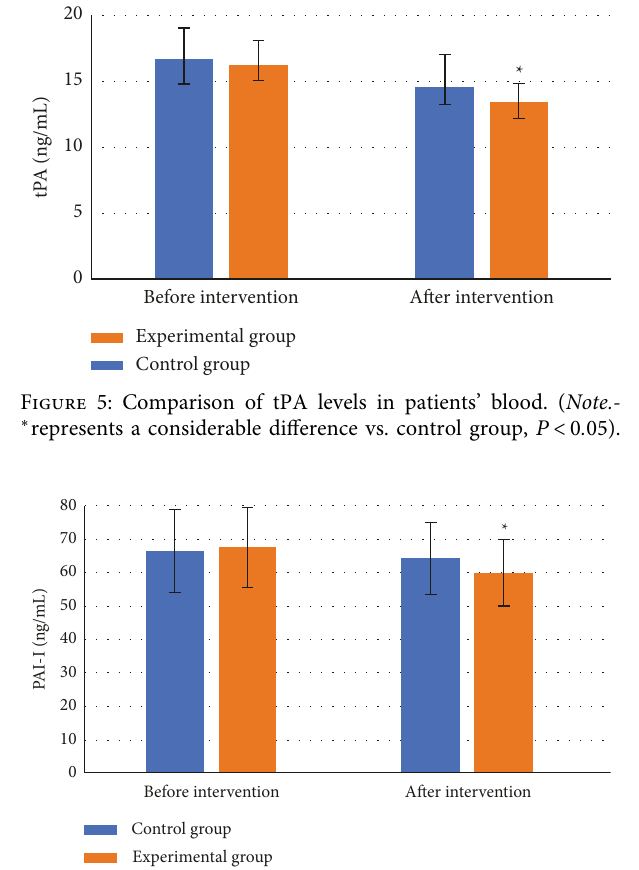
Figure 6: Comparison of blood PA1-1 levels of patients. ( Note.- ∗ represents a considerable difference vs. control group, P < 0 . 05).